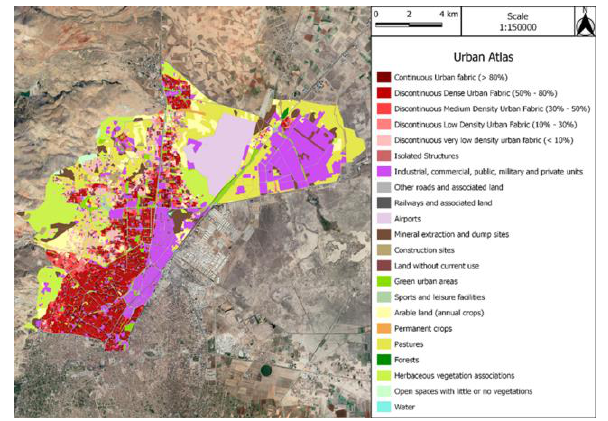
Figure 4. Land use Urban Atlas Map 2018